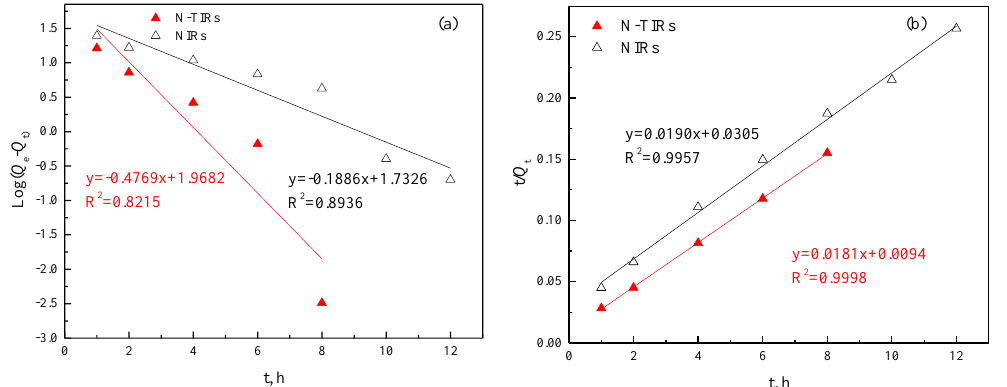
Figure 9. Fitting of the pseudo-first order kinetic ( a ) and pseudo-second order kinetic model ( b ) for V(V) adsorption onto N-TIRs and NIRs. Table 3. Fitting parameters of the kinetic models for V(V) adsorption onto the SIRs. Pseudo-First SIRs